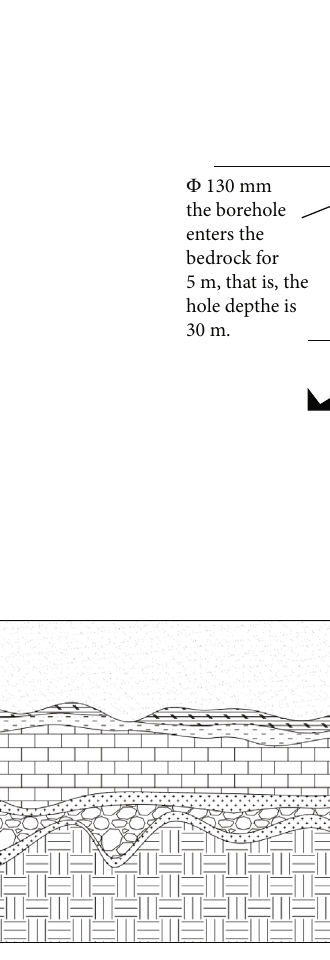
Figure 11: Schematic diagram of formation lithology in goaf. Note: (1) the loose deposit of the Quaternary; (2) Permian sand shale; (3) mudstone; (4) Carboniferous limestone; (5) clay rock; (6) bauxite; (7) Ordovician limestone.